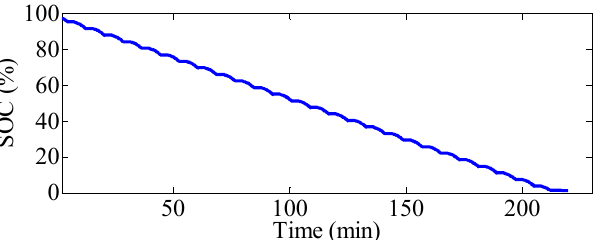
Figure 5. Reference state of charge (SOC) in the sensor fault-free condition.